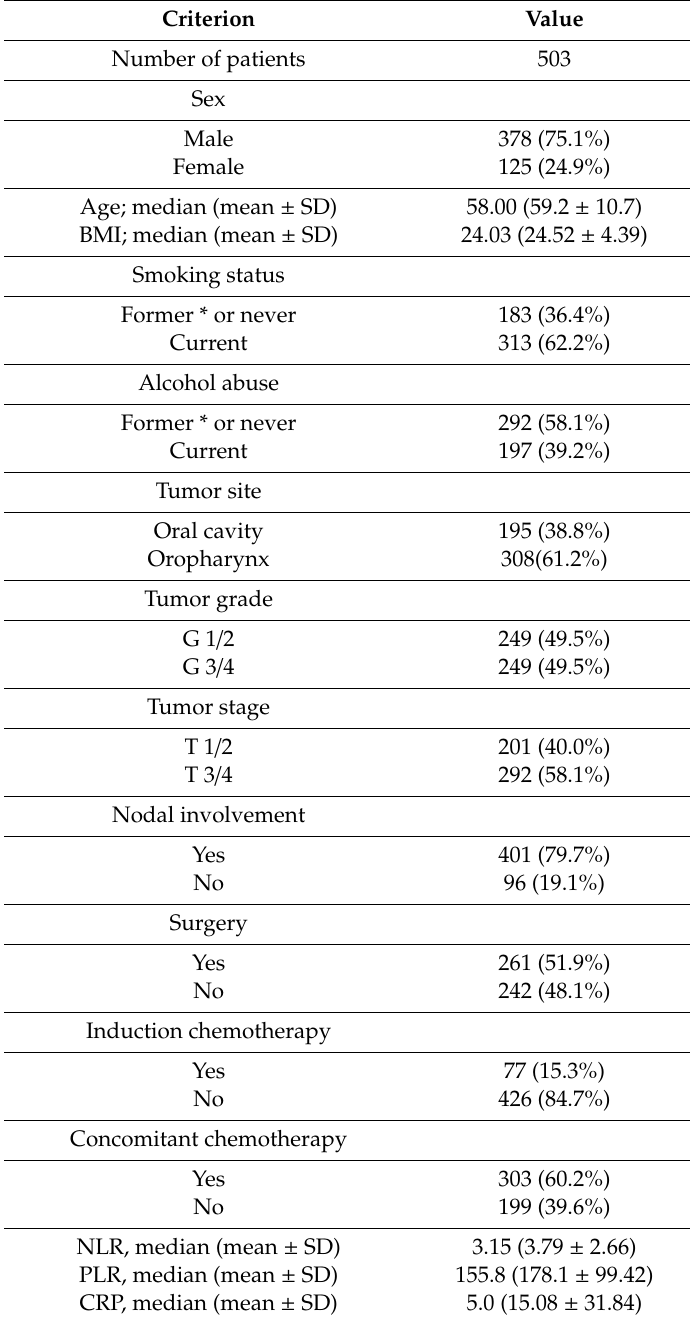
Table 1. Summary of patient